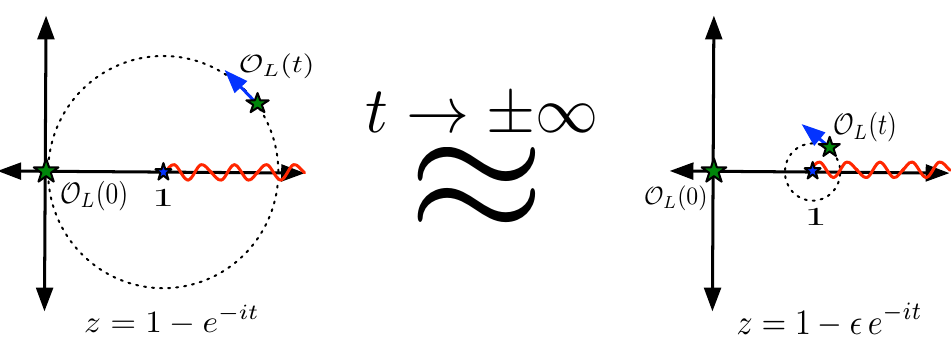
Figure 6 . This (cid:12)gure suggests how the large time behavior of the heavy-light correlator can be obtained by taking winding of z roughly j t j by expanding at small the interpretation of this time-dependence in AdS.